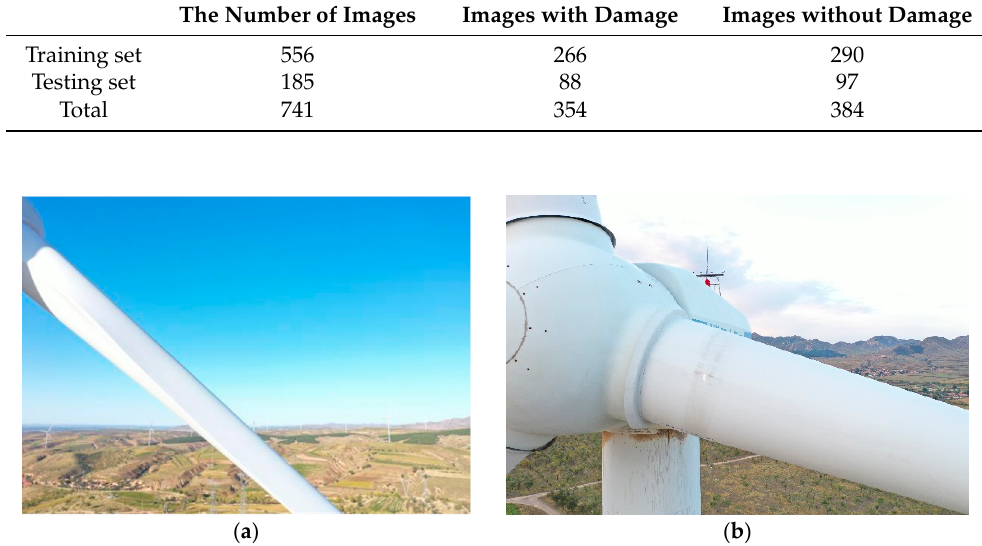
Figure 2. The collected images of wind turbine blades. ( a ) A wind turbine blade without damage; ( b ) a wind turbine blade with damage. Table 1. The details of the image dataset.